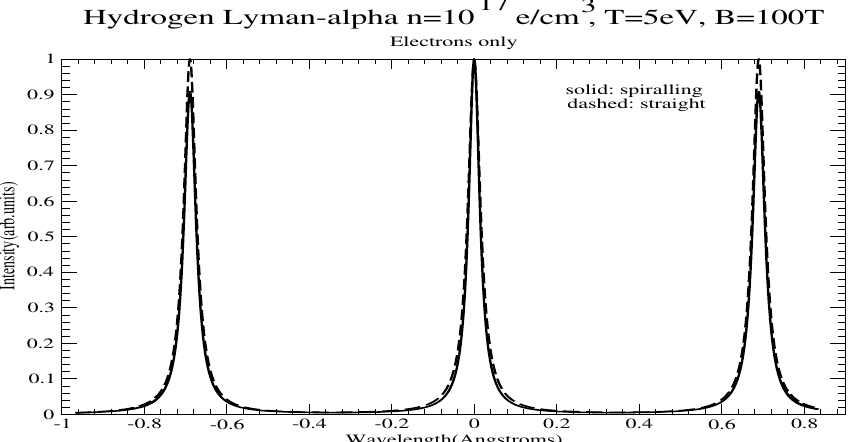
Figure 4. Line profile of the Ly − α transitions with and without account of spiralling for n = 10 17 e/cm 3 , T = 5 eV and B = 100 T. 10,000 configurations were used in this